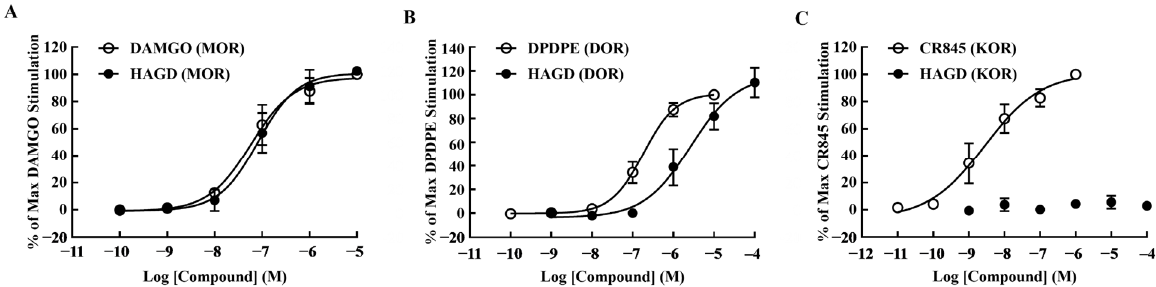
Figure 1. Agonistic activity of HAGD in calcium mobilization assays. Drug dosage was in mol/L in ( A ) CHO hMOP , ( B ) CHO hDOP , and ( C ) CHO hKOP cells. CHO hMOP , CHO hDOP , and CHO hKOP : Chinese hamster ovary cells expressing human mu, delta, and kappa opioid receptors, respectively. MOR, mu opioid receptor; DOR, delta opioid receptor; KOR, kappa opioid receptor; M, mol/L.